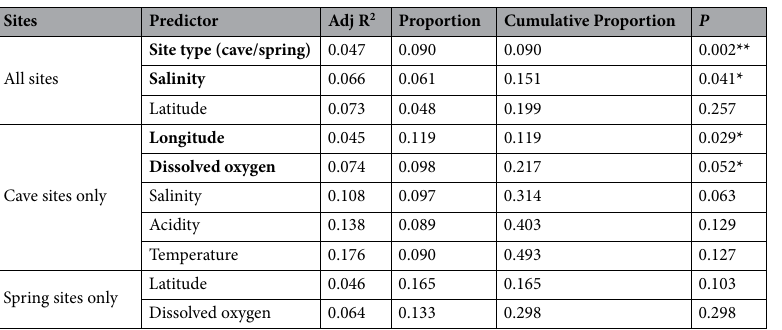
Table 4. Summary table of the distance based linear model (DistLM) analyses for subterranean fauna. These were constructed using a sequential step-wise selection procedure and adjusted R 2 criterion. Significant codes are as follows: 0 < 0.001 ‘***’, 0.001 < 0.01 ‘**’, 0.01 < 0.05 ‘*’. The predictor variables highlighted in bold are significant (P < 0.05). Full DistLM results, including marginal tests and best solutions, are provided in Table